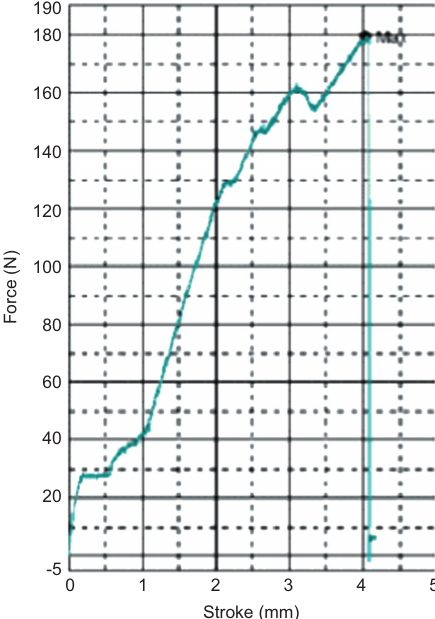
carbon/epoxy 10